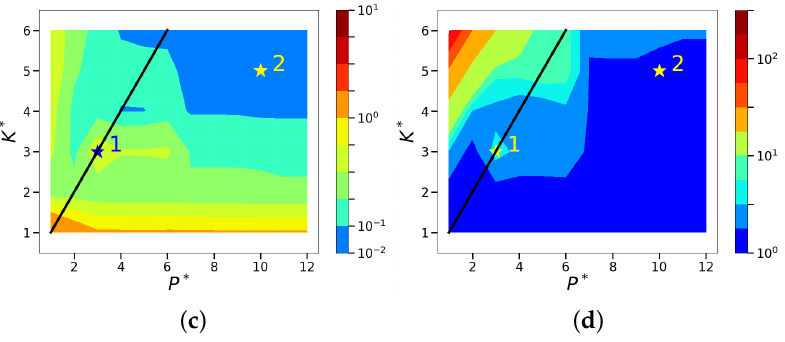
Figure A5. The isocontours of the normalized mean squared POD-based sparse reconstruction errors ( l 2 norms). The top figures correspond to the case with mean removed for learning the basis. The bottom figures correspond to the case with the mean retained. Left: normalized absolute error metric, (cid:101) 1 . Right: normalized relative error metric, (cid:101) 2 . ( a ) (cid:101) 1 (without mean); ( b ) (cid:101) 2 (without mean); ( c ) (cid:101) 1 (with mean); and ( d ) (cid:101) 2 (with